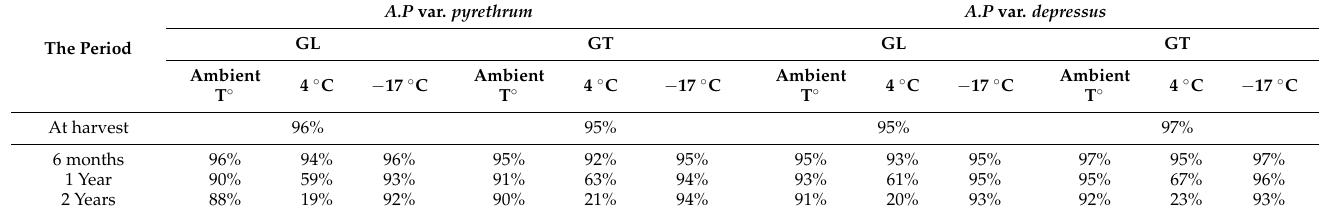
Table 7. Viability of different types of seed (GL: peripheral seeds; GT: central seeds) as a function of time and storage method.